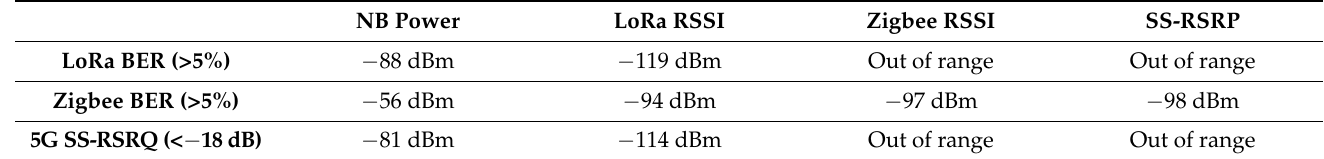
Table 4. BER predictions from measurement.